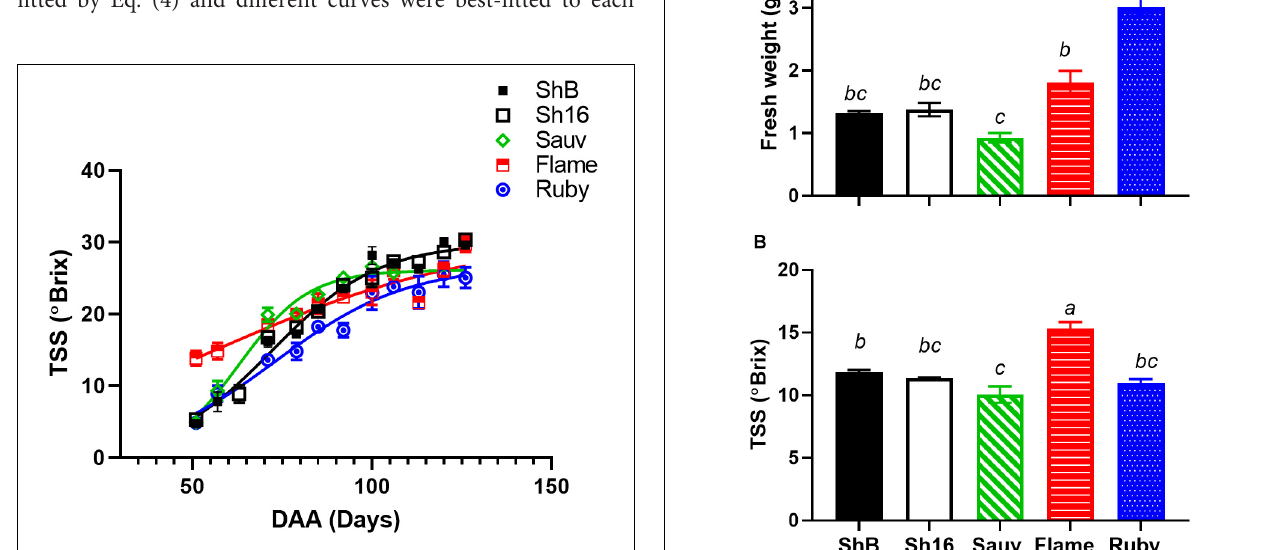
FIGURE 2 | Fresh weight (A) and total soluble solids (TSS) (B) of Shiraz BVRC12 (ShB) and 1654 (Sh16), Sauvignon Blanc (Sauv), Flame Seedless (Flame), and Ruby Seedless (Ruby) at around 65 DAA in season 2018/2019 [ n = 3 in (A) , n = 4 in (B) , mean ± s.e.m.]. Different lower-case letters indicate statistical differences (One-way ANOVA, Tukey’s test, P <